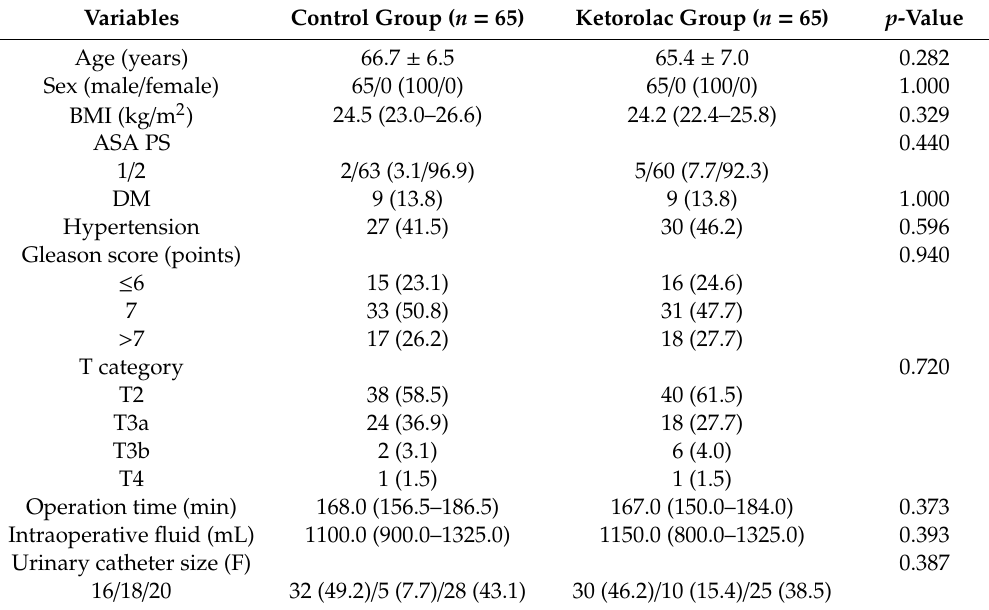
Table 1. Characteristics of study